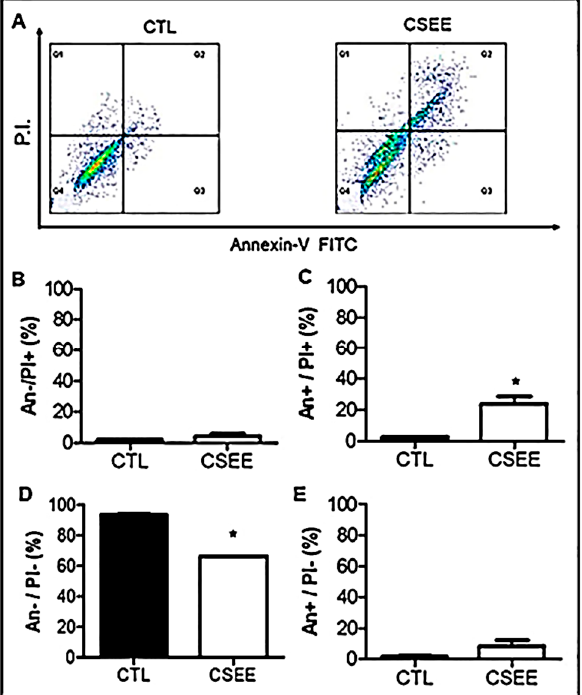
Figure 5. Effects of CSEE on phosphatidylserine externalization in cells SH-SY5Y. Annexin V-FITC/PI